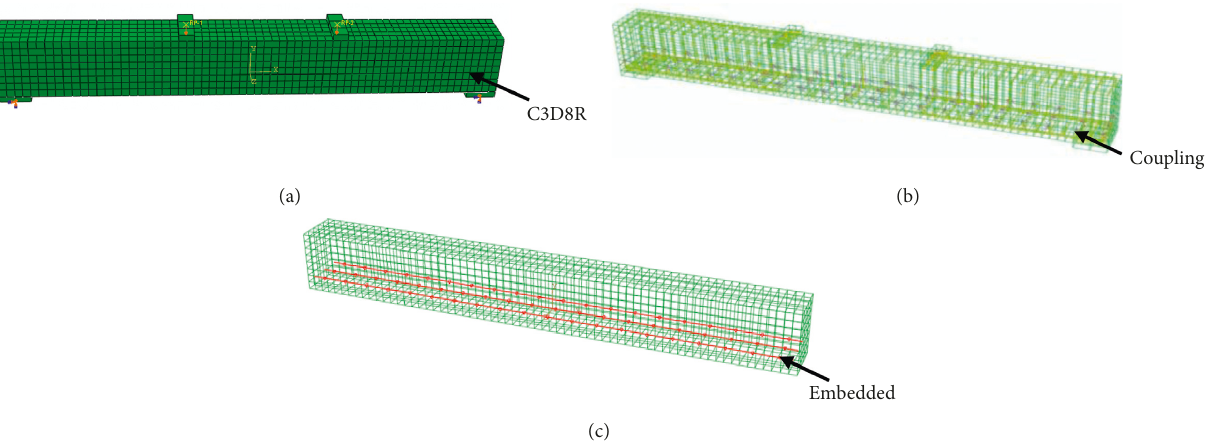
Figure 8: FE model. (a) Mesh of concrete C3D8R element. (b) Contact between prestressed tendons and concrete of unbonded PC model. (c) Contact between prestressed tendons and concrete of bonded PC